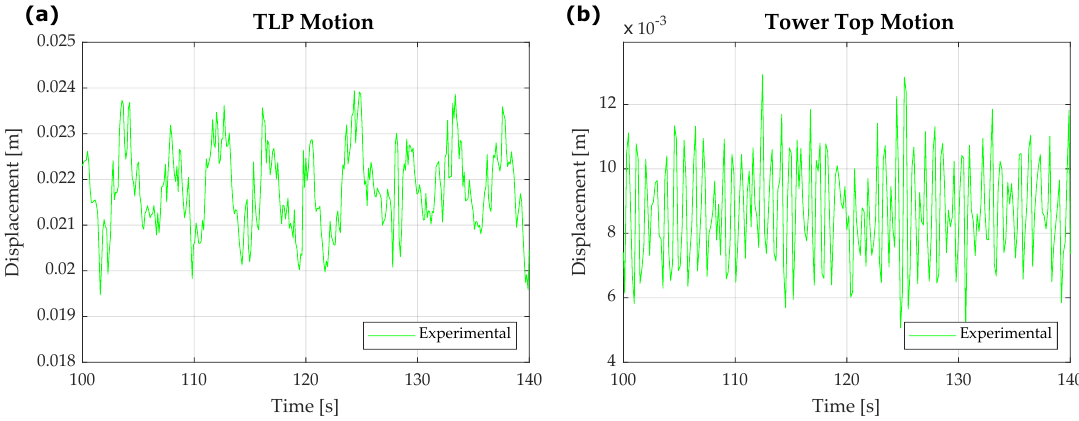
Figure 11. ( a ) Experimental time series data of the displacement of the TLP at a wind speed of 7 m/s and monochromatic waves with a wave height of 0.01 m and wave frequency of 0.6 Hz. ( b ) Experimental time series data of the displacement of the tower top at a wind speed of 7 m/s and monochromatic waves with a wave height of 0.01 m and wave frequency of 0.6 Hz.